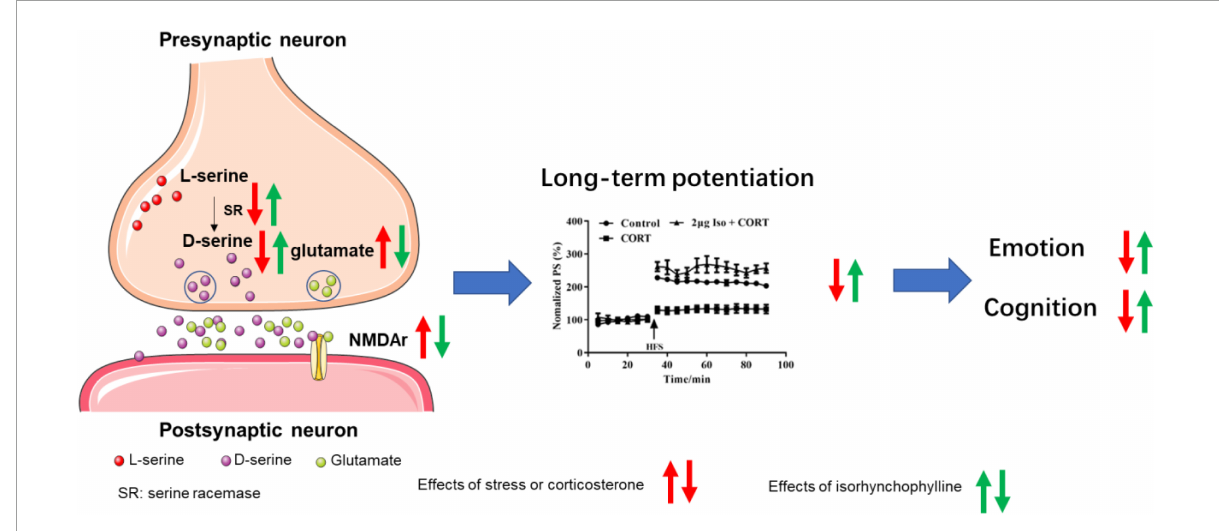
FIGURE6 Sketch map for the mechanisms of isorhynchophylline on CUMS induced emotional disorders and cognitive